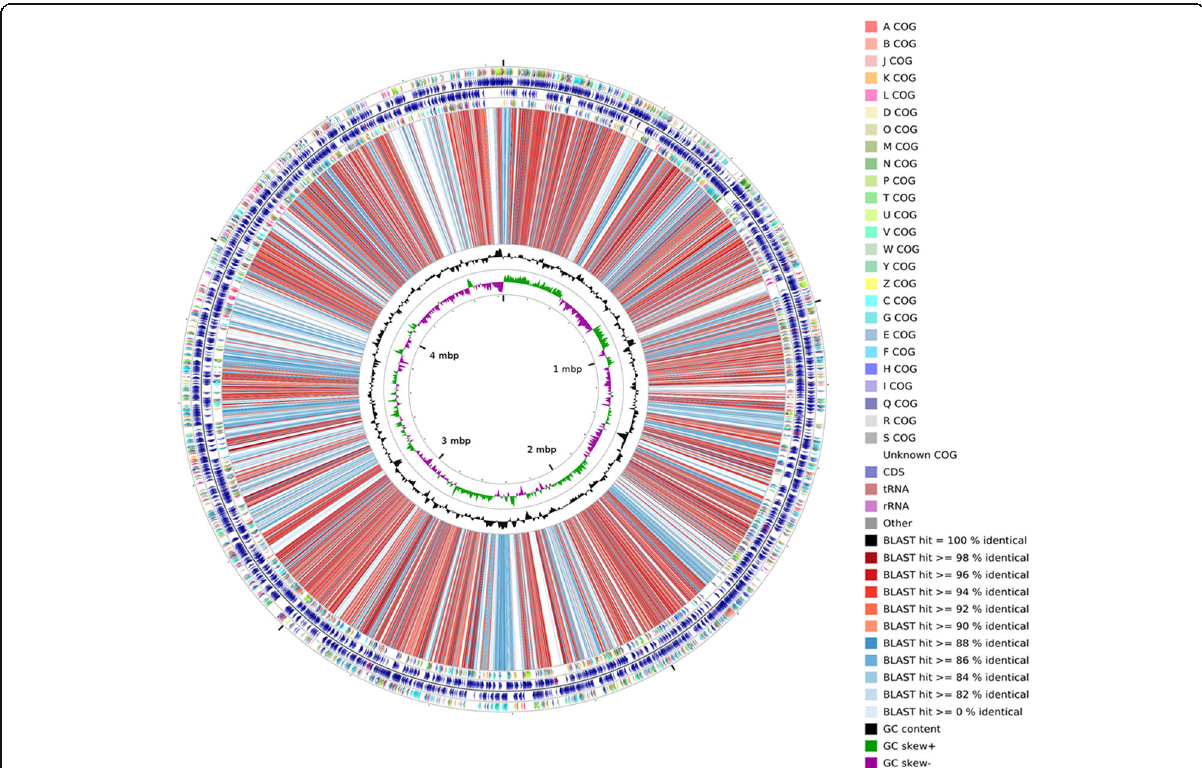
Fig. 5 A graphical circular map of the comparison between strain P. manganicus JH-7 T and P. salicylatoxidans KCT001. From outside to center, rings 1, 4 show protein-coding genes colored by COG categories on forward/reverse strand; rings 2, 3 denote genes on forward/reverse strand; rings 5 show the CDS vs CDS BLAST results of strain JH-7 T with strain KCT001; ring 6 shows G + C % content plot and the innermost ring shows GC